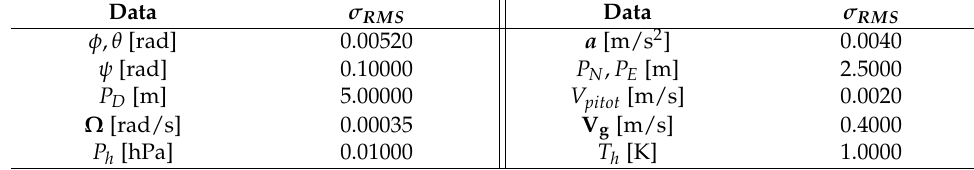
Table 2. Sensor noise specification ( w y